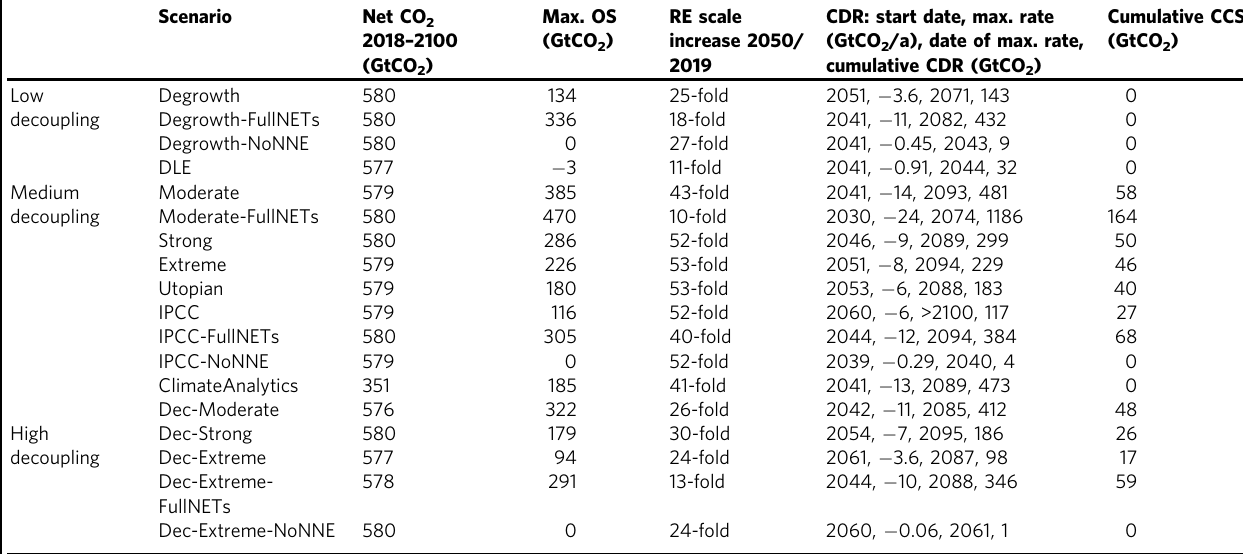
Table 2 Summary of the main results of the different scenarios.